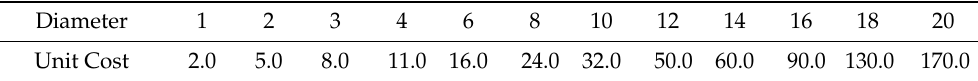
Figure 4. Graphical representation of large network introduced by Alperovits and Shamir. Table 4. Diameter options and associated unit costs for large